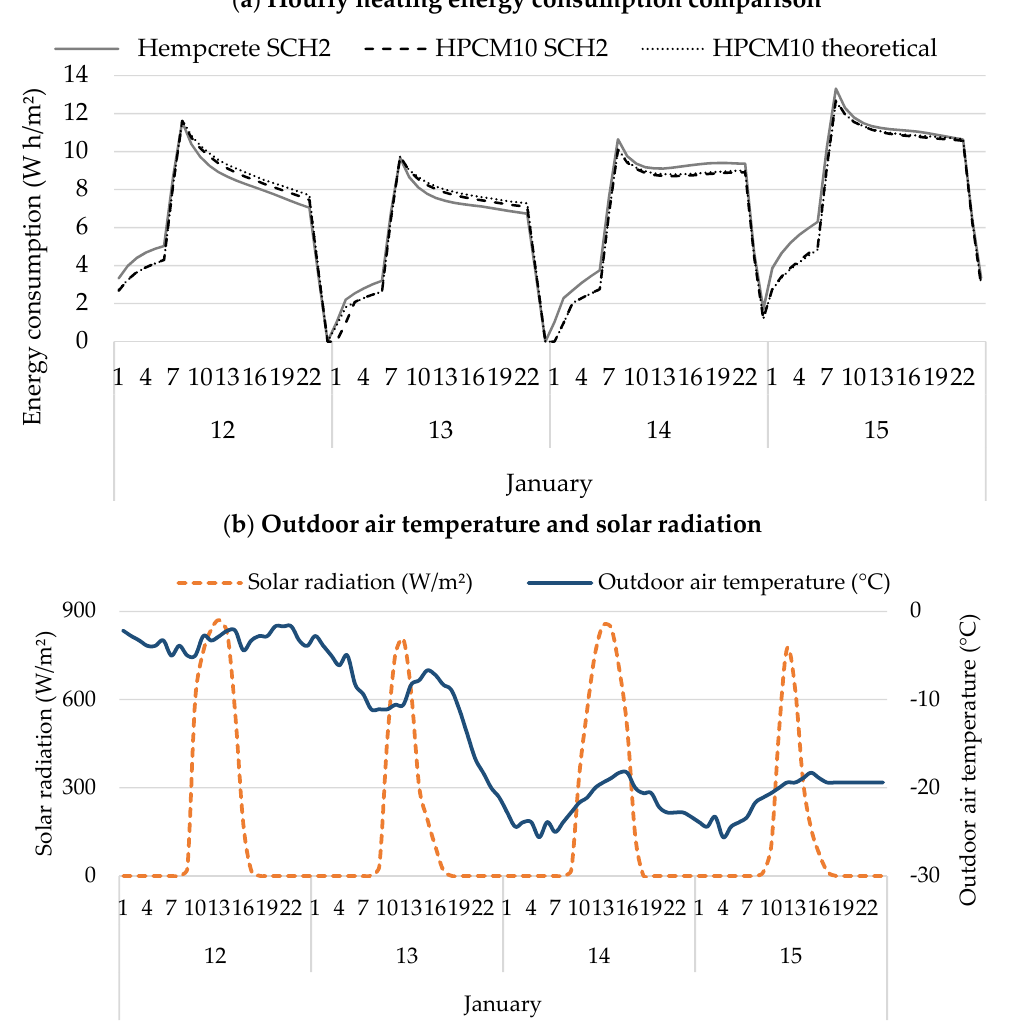
Figure 11. ( a ) Hourly heating energy consumption under SCH2 along with ( b ) solar radiation and outdoor air temperatures from January 12th to 15th.